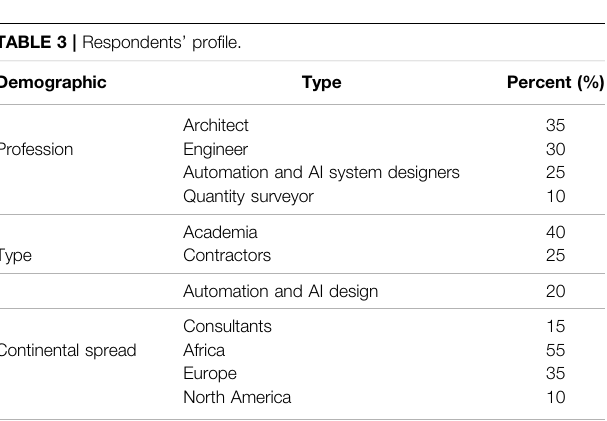
TABLE 3 | Respondents ’ pro fi